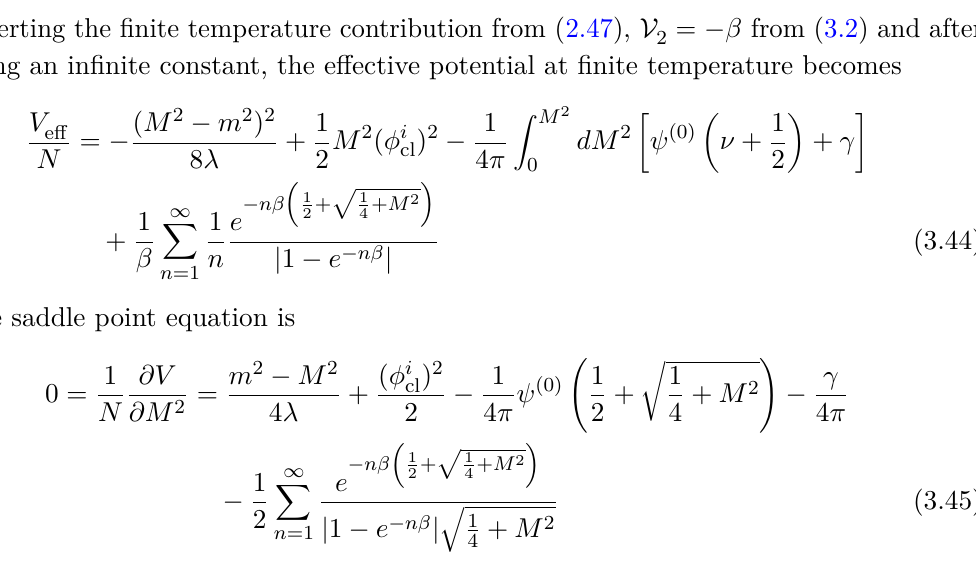
Figure 8. Phases and M 2 = 0 plots for AdS 2